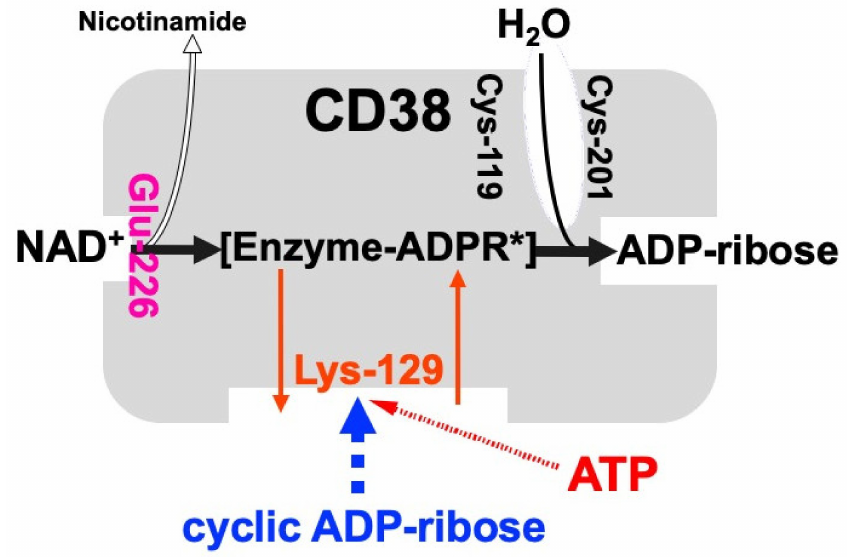
Figure 2. Schematic representation of human CD38 in enzyme activities for the synthesis and hydrolysis of cADPR (adapted from [26]). Glu-226 in human CD38 is essential for cADPR synthesis from NAD + (ADP-ribosyl cyclase activity) [46]. Cys-119 and Cys-201 are essential for cADPR hydrolysis to form ADP-ribose (cADPR hydrolase activity). Lys-129 is the cADPR binding site and is indispensable for cADPR hydrolysis (cADPR hydrolase) [21]. ATP, produced by glucose metabolism, competes with cADPR for the binding site (Lys-129), inhibiting the cADPR hydrolysis by cADPR hydrolase of CD38, which causes the accumulation of cADPR in the cell [12]. [Enzyme-cADPR*] is proposed as an enzyme-stabilized ADP-ribosyl oxocarbonium ion